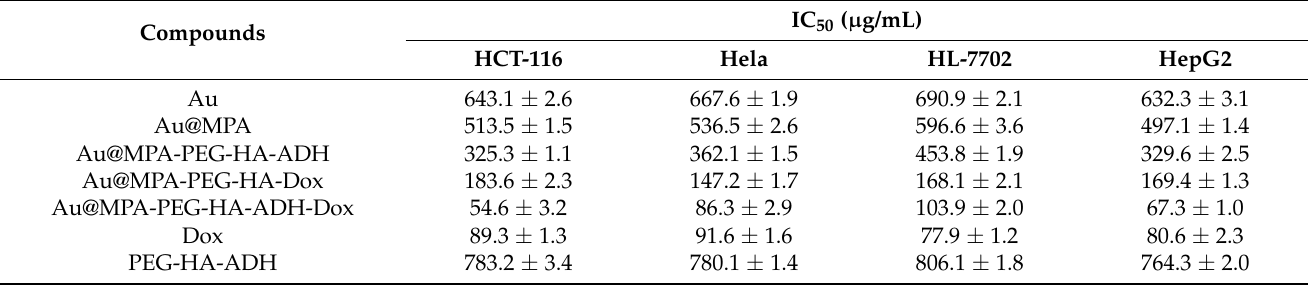
Table 1. IC 50 of gold nanoparticles (AuNPs) before and after modification.